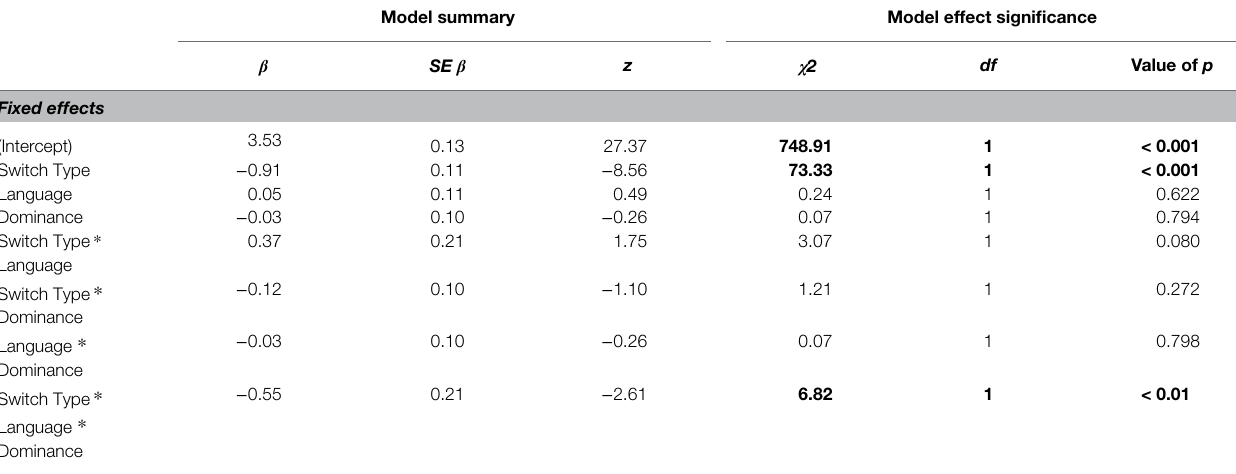
TABLE 2 | Results for logistic mixed-effects model of accuracy probability in the picture naming task.